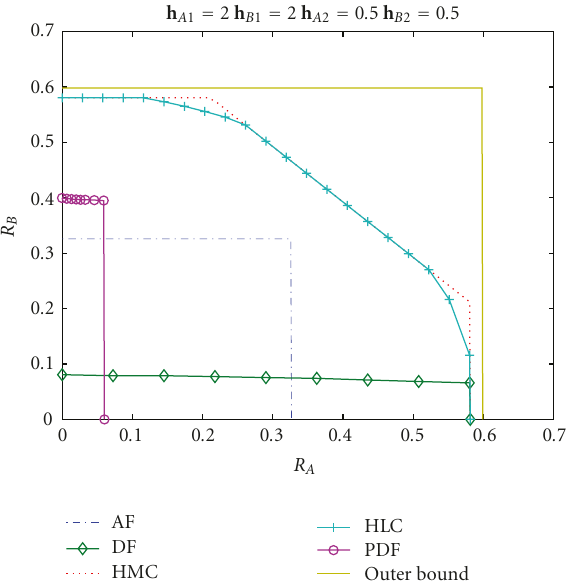
Figure 4: The achievable rate regions when one relay has large link gains (symmetric case).